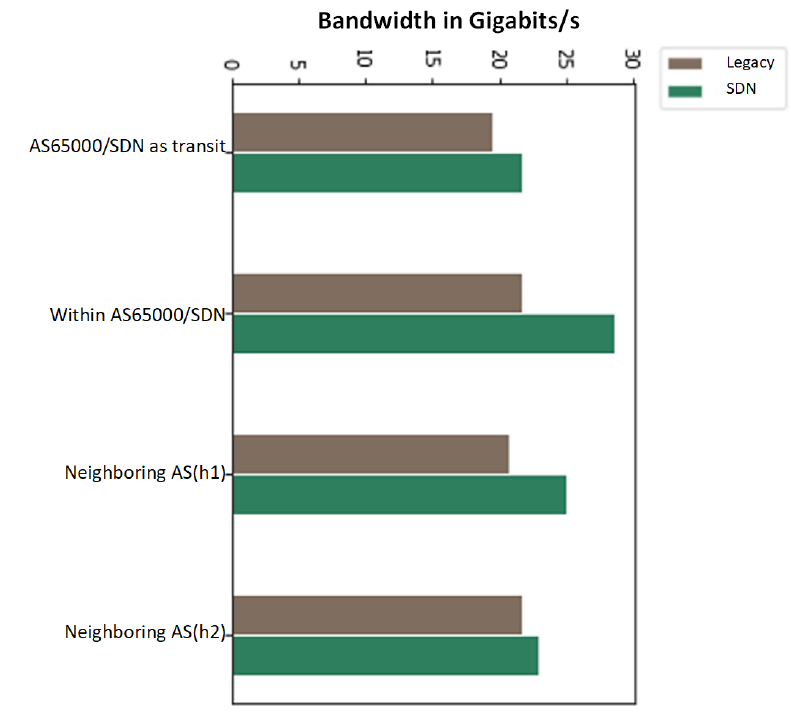
Figure 9. Bandwidth capacity for SDN and legacy